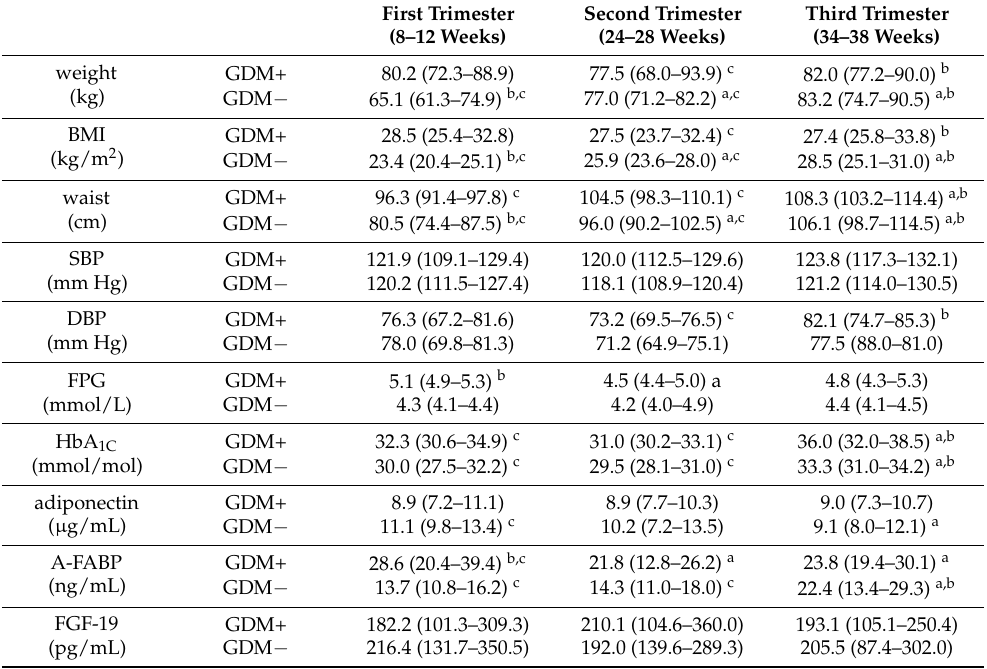
Table 2. Changes in selected clinical parameters, glucose control, and adipokines during pregnancy in women with and without GDM.